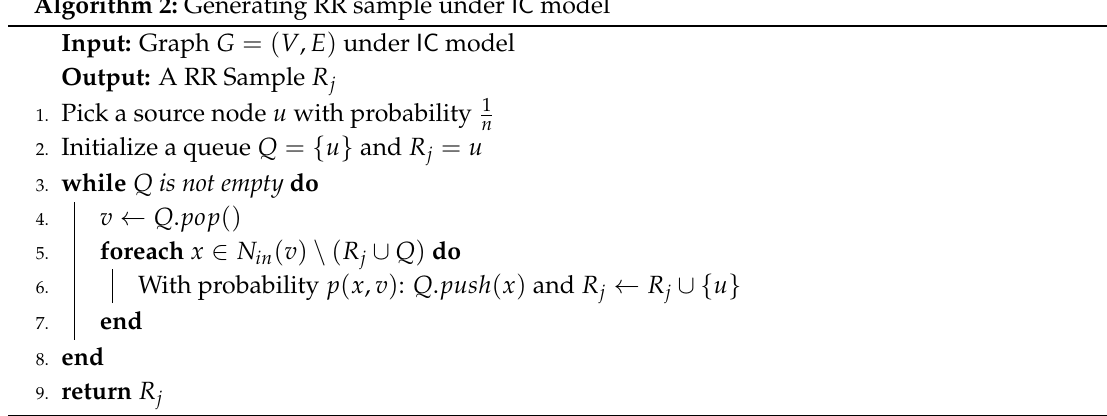
Algorithm 2: Generating RR sample under IC